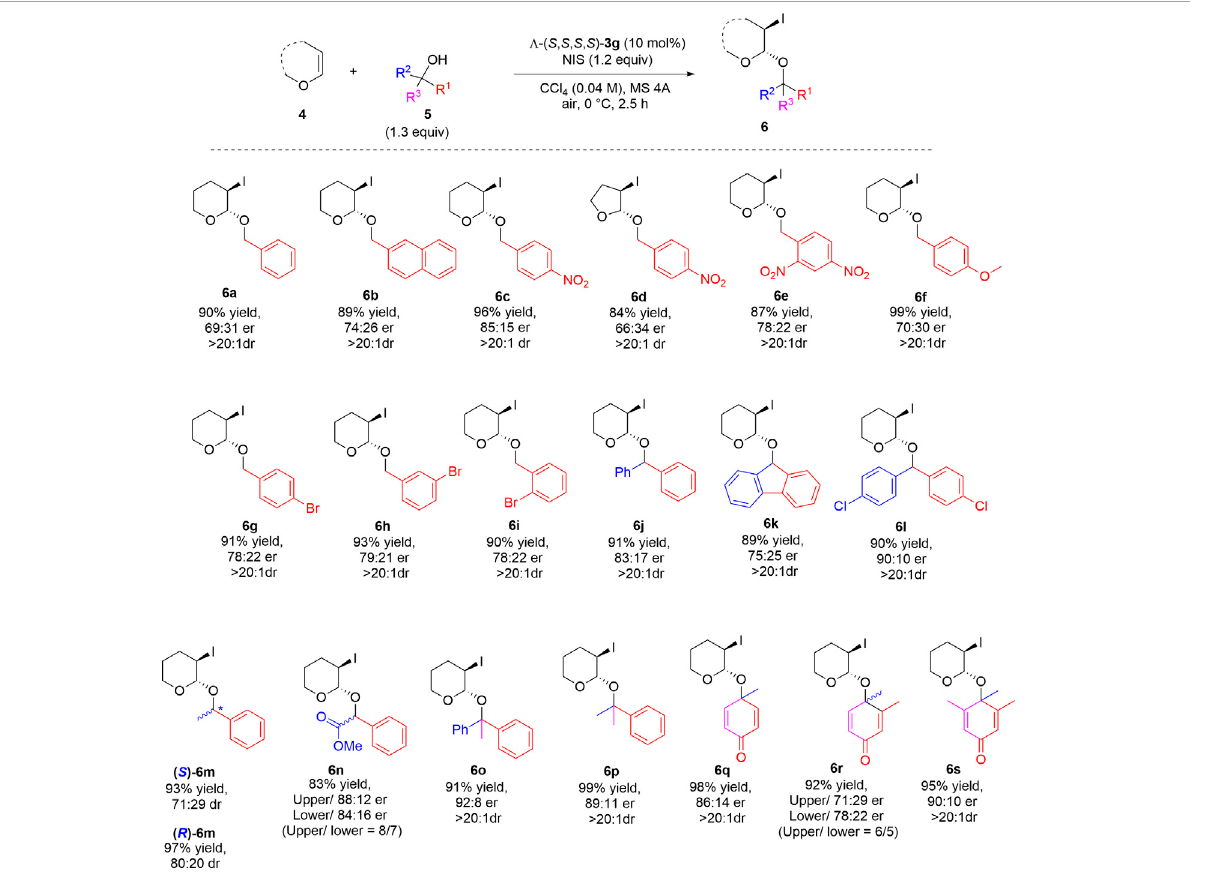
TABLE 4 Iodoacetalization of enol